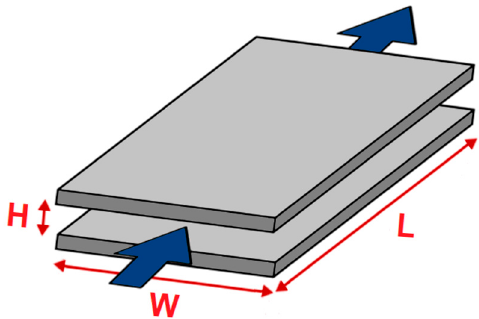
Figure 2. Scheme of the rectangular slit channel between adjacent solid samples with a planar surface. L, W and H are the length, width and height of the flow channel, respectively.